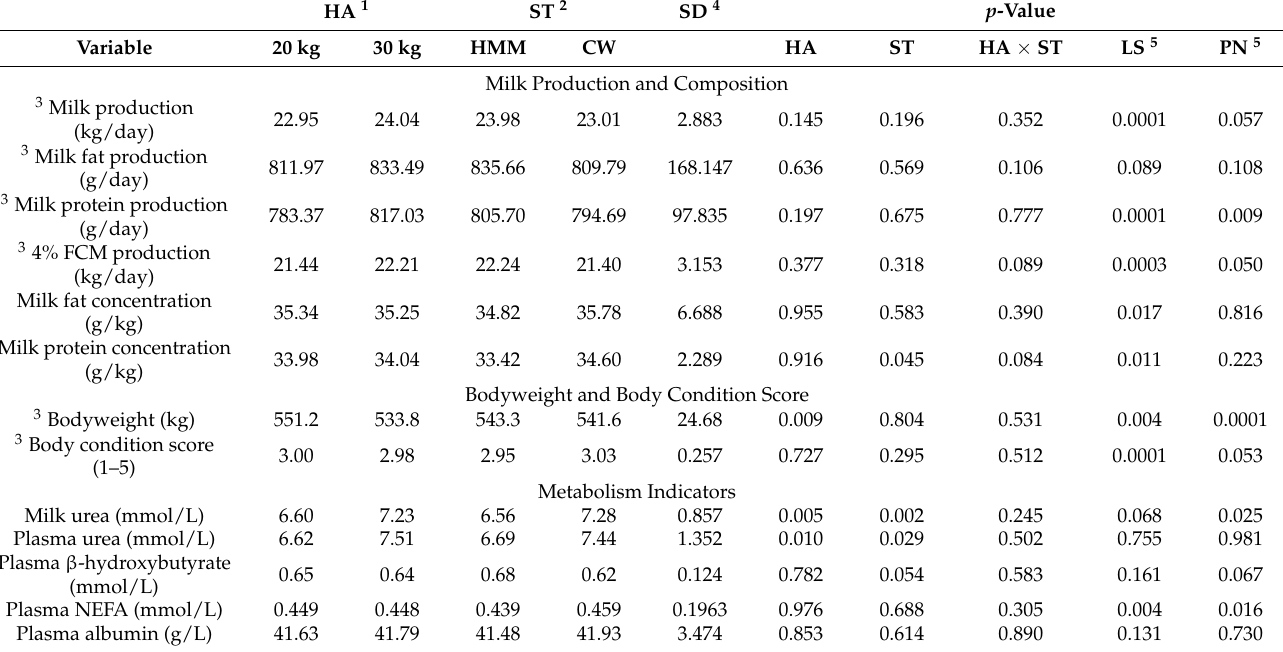
Table 3. Effect of herbage allowance and supplement type level on animal performance and metabolic indicators in the blood of lactating dairy cows ( n =